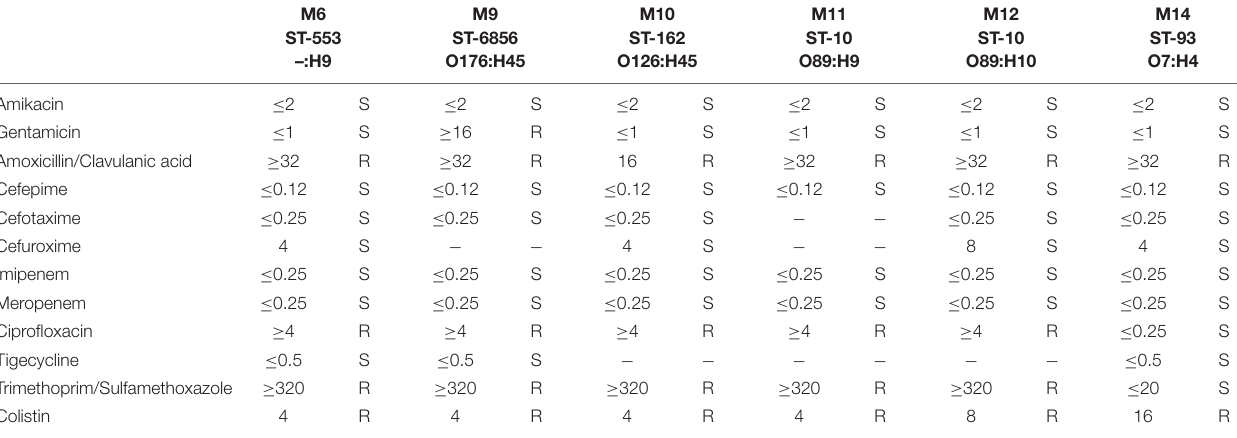
TABLE 2 | Antimicrobial susceptibility of extraintestinal mcr- 1.1-producing E. coli strains. M6